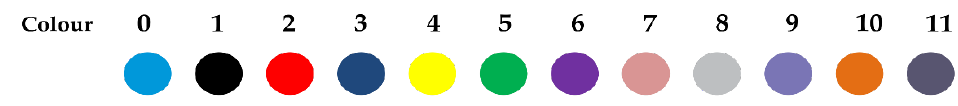
Figure 4. Coloring spectrum used for the graph.